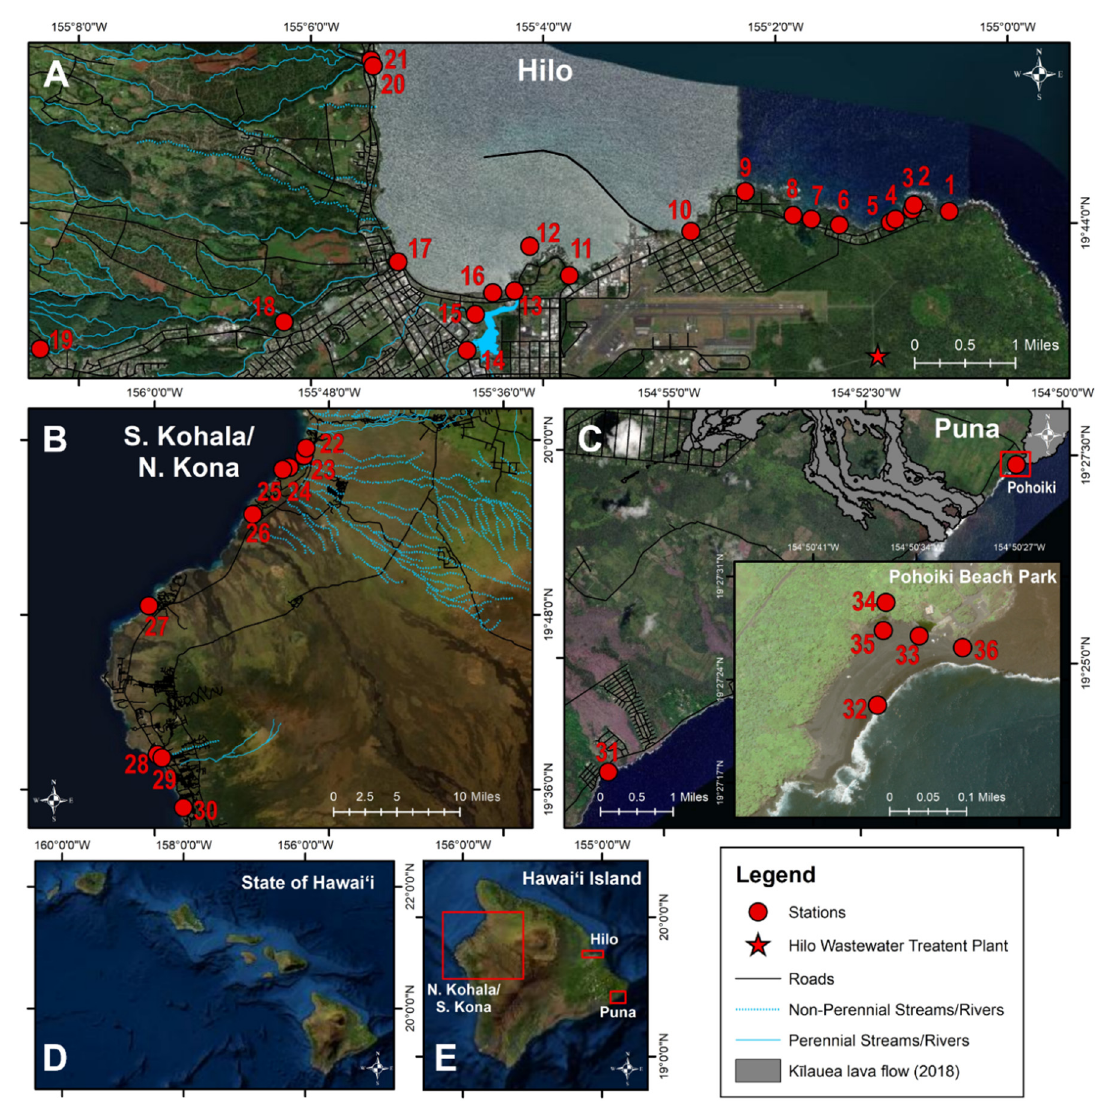
Figure 5. Map of water sampling stations. Sampling was conducted at 36 water (beach/river/stream/anchialine pool) and sand stations in the districts of ( A ) Hilo (station #1–21), ( B ) S. Kohala, N. Kona (station #22–30), and ( C ) Puna (station #31–36) on ( D ) Hawai ‘ i Island, ( E ) Hawai ‘ i from June to December